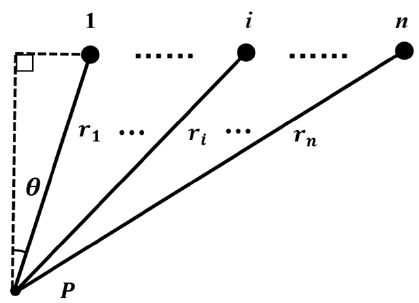
scribed in Figure 3.